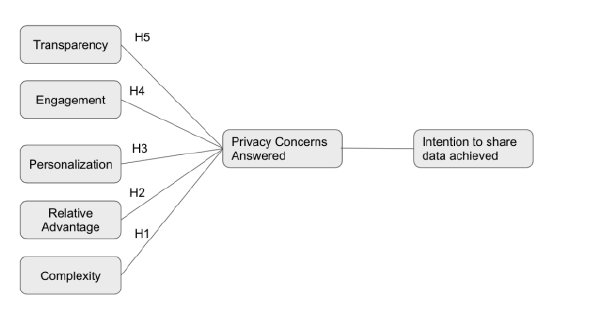
Figure 1 . The suggested